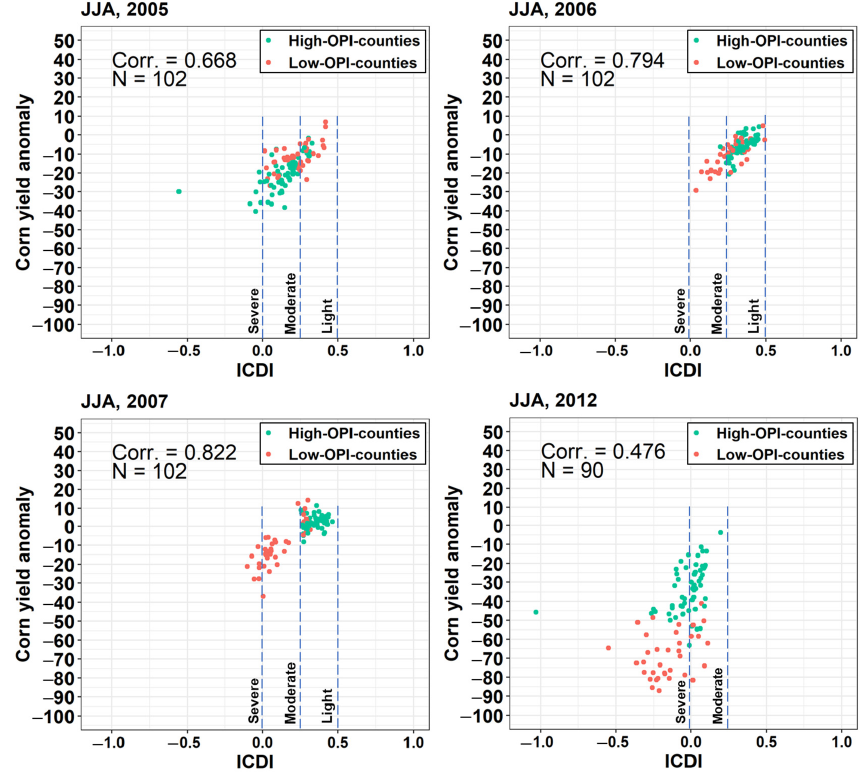
Figure 13. Relationship between the average ICDI in summer (JJA) and the corn yield anomaly for the drought years (2005, 2006, 2007, and 2012).